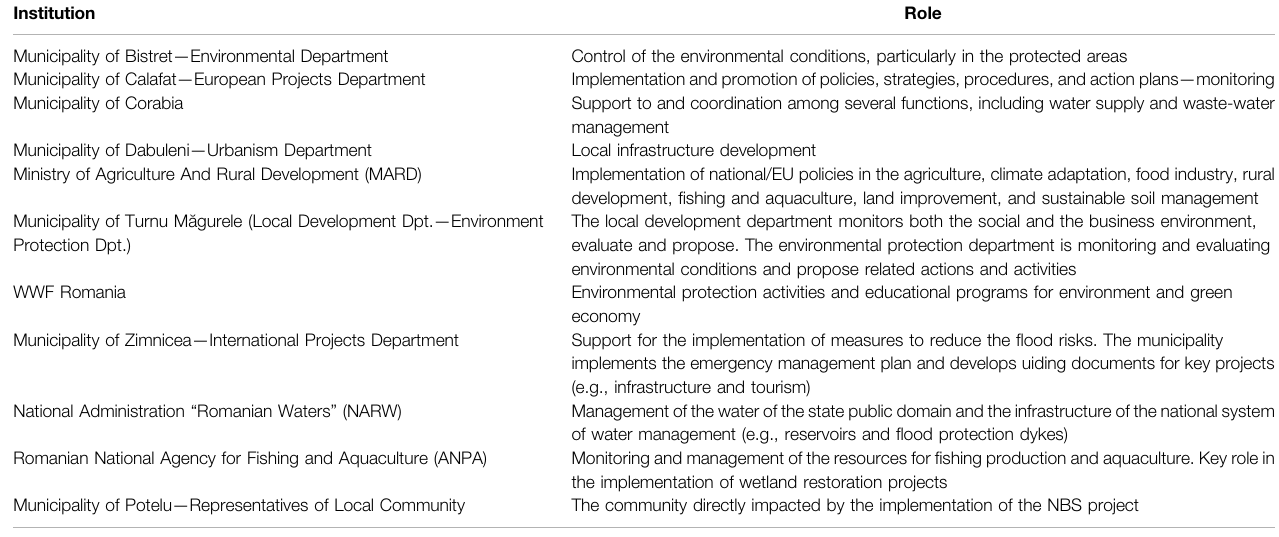
TABLE 2 | List of the stakeholders involved in the case study activities.